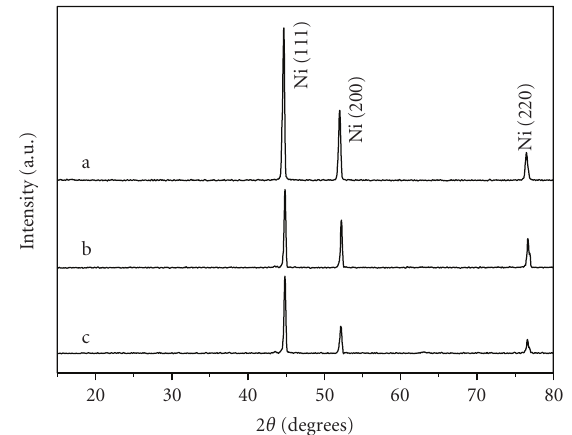
Figure 4: XRD patterns of bare-foam nickel (a), S1 (b), and S2 (c).